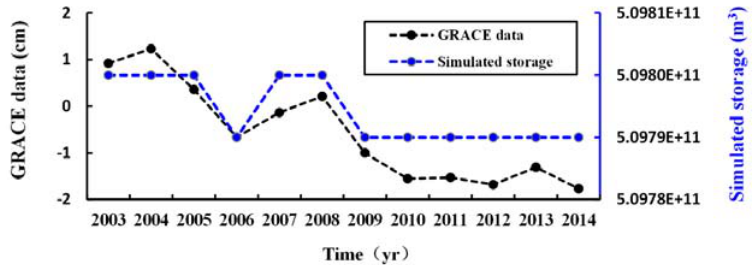
Figure 11. Comparison between the simulated and GRACE ‐ derived TWS variations.